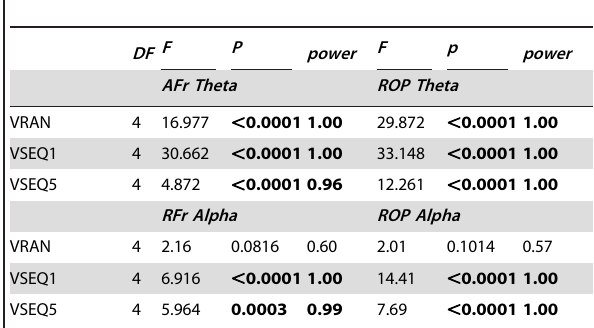
Table 2. Repeated measures ANOVAs in ROP (right occipito- parietal), AFr (Anterior Frontal) and RF (Right Frontal) areas for Theta and Alpha